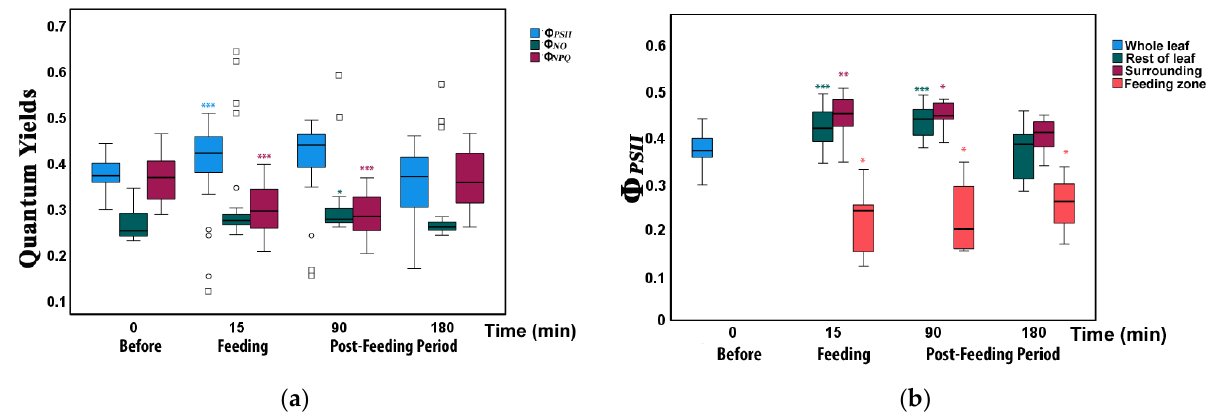
Figure 3. Light energy utilization in photosystem II of tomato leaflets before (0 min), immediately after insect feeding (15 min), and post-feeding period (90 and 180 min). ( a ) Allocation at the whole leaflet of absorbed light energy for photochemistry ( Φ PS ΙΙ , blue), regulated non-photochemical energy loss ( Φ NPQ , dark green), and non-regulated energy loss ( Φ NO , dark red). ( b ) The effective quantum yield of photochemistry ( Φ PS ΙΙ ) for the whole leaflet (blue), in the feeding zone (light red), the zone surrounding the feeding zone (dark red), and in the rest of the leaflet (dark green). Boxes and whiskers indicate the tenth, twenty-fifth, fiftieth, seventy-fifth, and ninetieth percentiles. Circles and squares indicate outliers. Asterisks indicate significant pairwise differences from the Before values: *: p < 0.05; **: p < 0.01; ***: p < 0.001.